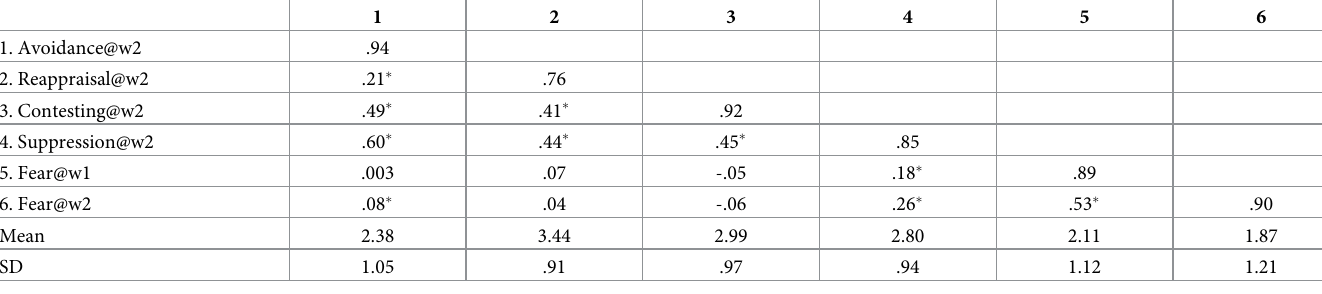
Table 2. Bivariate correlations and descriptive statistics for manifest variables in (mostly) wave